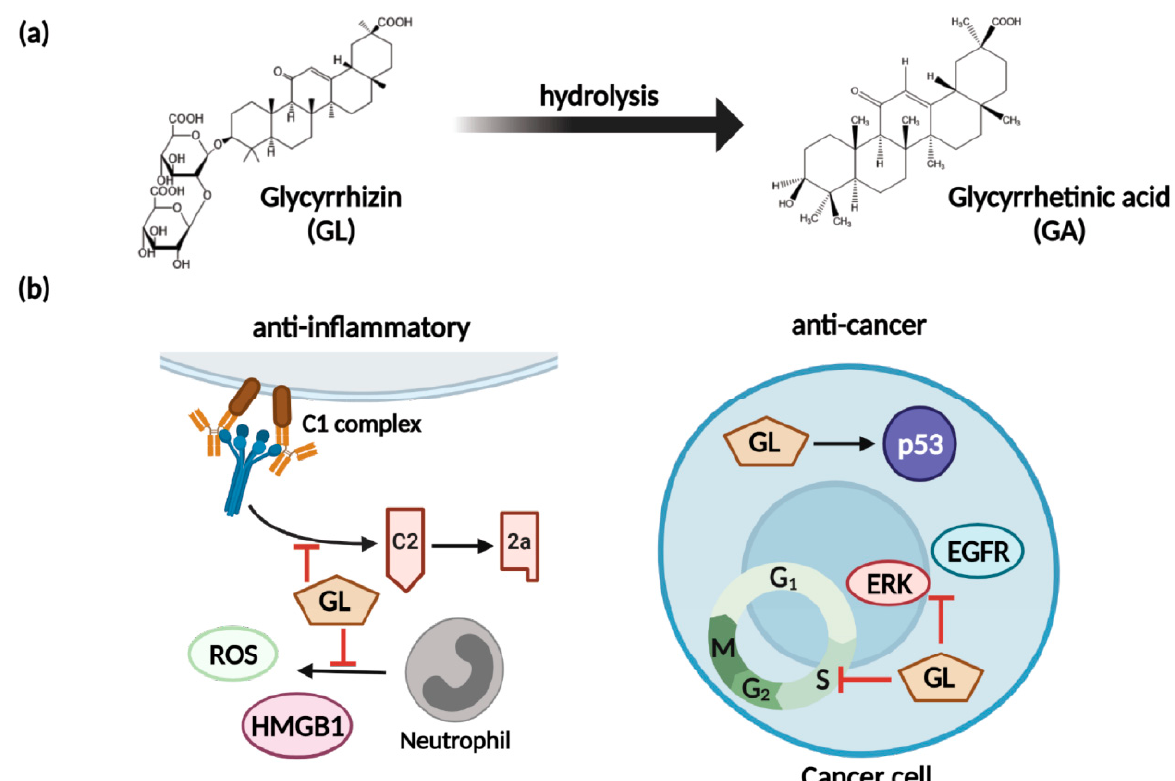
Figure 4. GL metabolism and activities. Image created with BioRender icons. ( a ) GL can be hydrolyzed to GA. ( b ) GL inhibits the cell cycle and ERK and EGFR phosphorylation and activates p53; GL inhibits the C2 pathway and production of ROS and inflammatory cytokines.